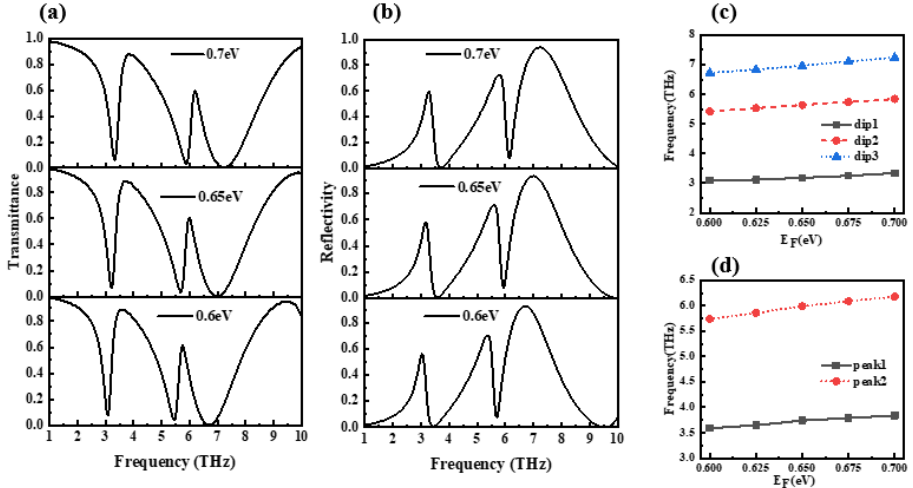
Figure 5. Variation of transmission characteristics with chemical potential. ( a ) Variation of transmis- sion spectrum with chemical potential. ( b ) Variation of reflection spectrum with chemical potential. ( c ) Trend of transmission spectrum dips. ( d ) Trend of transmission spectrum peaks.